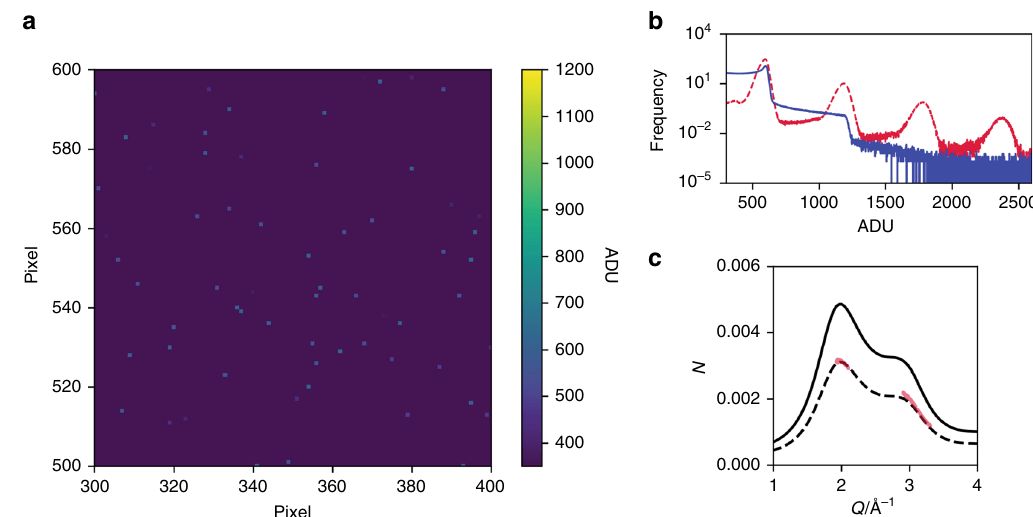
Fig. 3 X-ray scattering from water. a Single split-pulse scattering pattern in a 100 × 100 pixel region of interest at around Q = 2.0 Å − 1 with I tot = 3.3 µ J and Δ t = 0.0 ps. The vertical and horizontal directions correspond to Q -direction and the azimuthal direction, respectively. b Histogram of the charge (in units of analog-to-digital units (ADU)) per shot in a 1024 × 512 pixel region. The blue solid line is the average histogram of the 287,982 raw images, and the red dashed line is after the droplet algorithm has been applied. The single-photon event corresponds to 595 ADU. c The number of photons at each pixel per shot obtained by averaging 35,899 shots with Δ t = 0.0 ps and 〈 I tot 〉 = 7.9 µ J. (red lines). The area around Q = 2.0 Å − 1 was covered by a single MPCCD and that around Q = 3.0 Å − 1 was covered by a dual MPCCD 42 . The solid black line is the estimation of X-ray elastic scattering using the result of high-energy X-ray diffraction intensity pro fi le 47 , the thickness of the sample, the X-ray energy, the size of a pixel, and the average number of X-ray photons for a single shot. The dashed line is × 0.64 of the solid line.